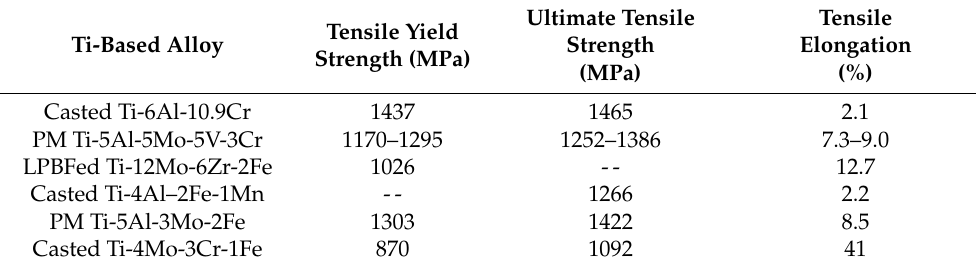
Table 2. Comparison of tensile properties of the Ti-6Al-10.9Cr alloy and other low-cost and high- strength Ti-based alloys adapted from literatures [47–51] (PM: powder metallurgy, LPBF: laser powder bed fusion).